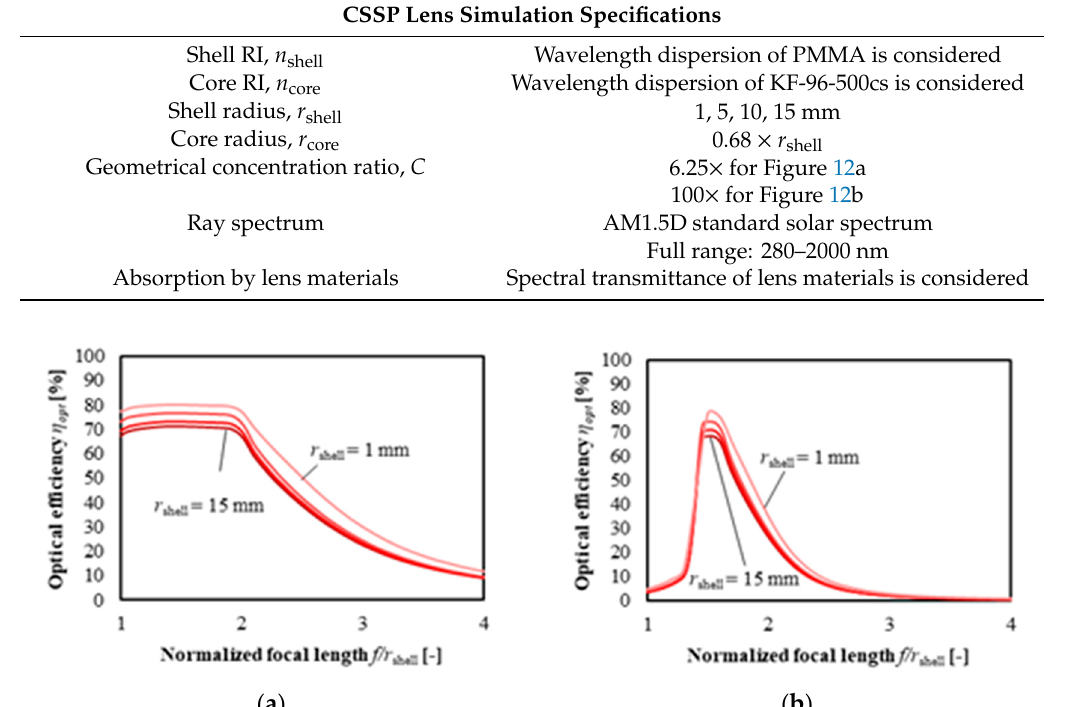
di ff erent shell radii lengths at ( a ) C = 6.25 × and ( b ) 100 × . different shell radii lengths at ( a ) C = 6.25 × and ( b ) 100 × .